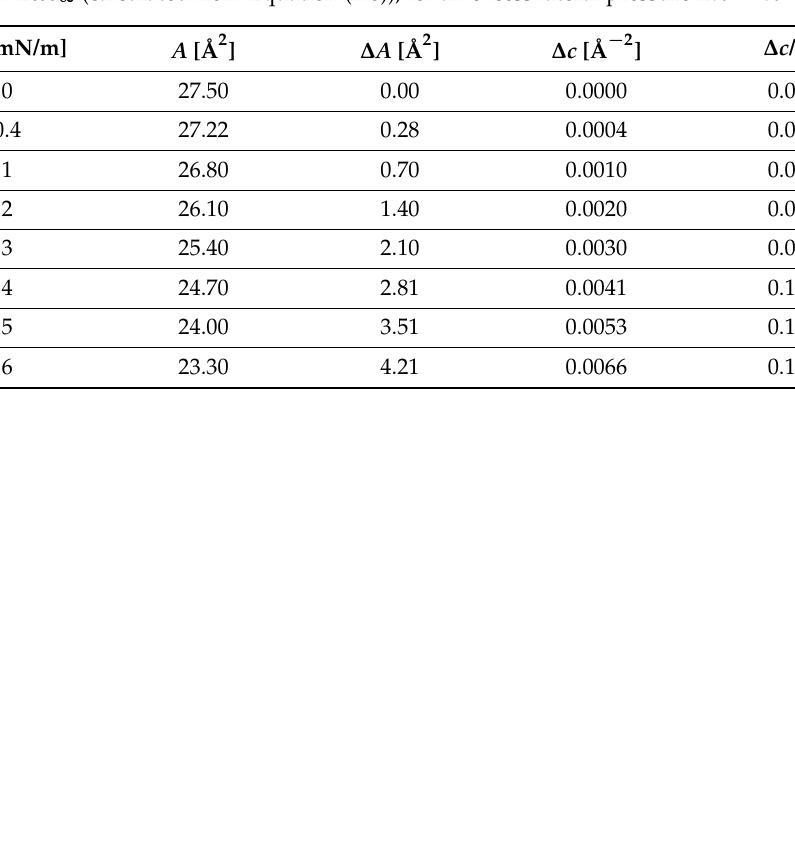
Table A1. Even at the highest lateral excess surface pressure of ≈ 5 mN / m, the normalized